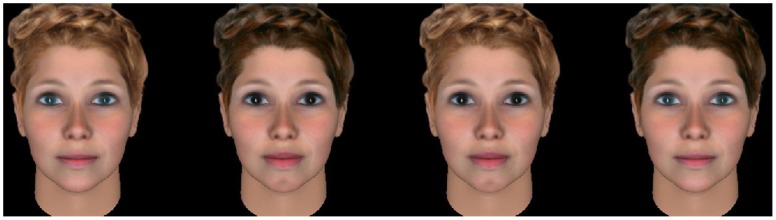
An example of a quartet used in Study 2.A Delphi-based computer program was used to present the virtual women’s faces. For a given rater, four faces of the same virtual woman were selected, depending on the rater’s own traits (initially recorded in the computer program by the observer; see table 1). These four faces corresponded to the four cases of preferences: homogamy (the face displayed similar character states as the rater), heterogamy (the face displayed opposite character states), recessivity (the face displayed recessive character states) and dominant (the face displayed dominant character states). The rater was instructed to click on the woman that he would prefer to build a family with. Images are from virtual subjects.